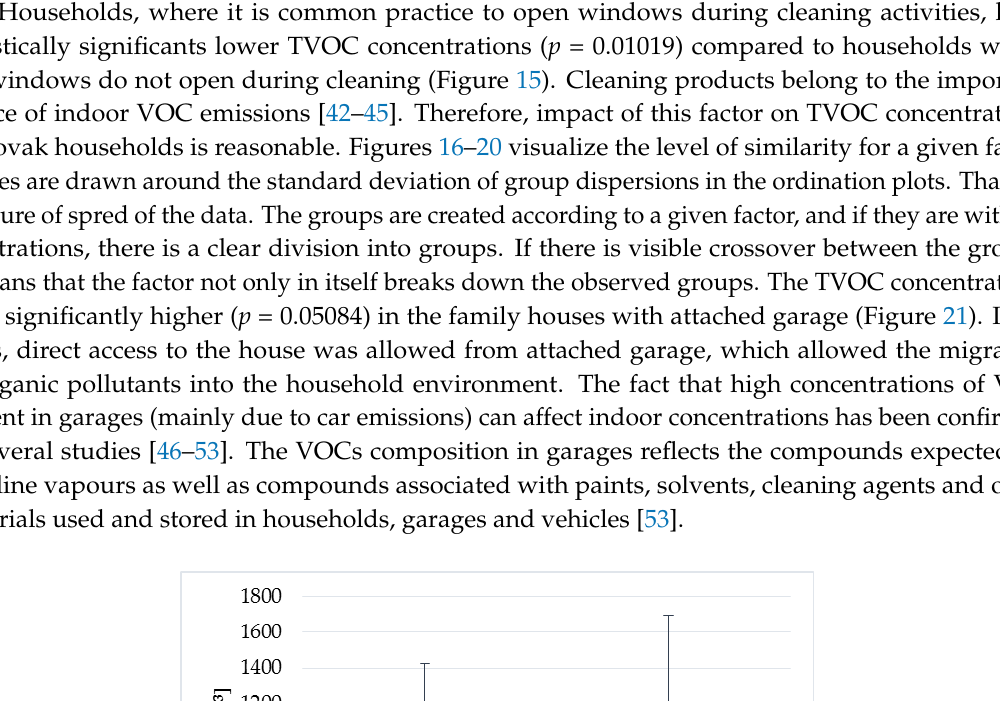
Figure 14. Boxplot of total medians—the apartments and family houses.